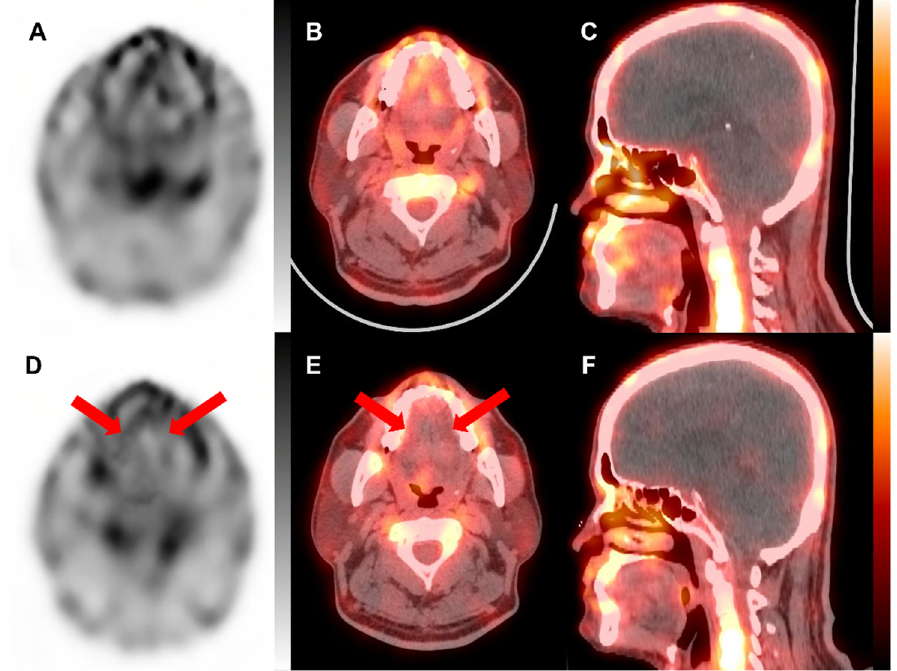
Figure 2. Transaxial single-photon emission computed tomography (SPECT), fused transaxial, and fused sagittal SPECT/computed tomography (CT) images of the tongue on the initial ( A – C ) and follow-up ( D – F ) blood pool SPECT/CT using Tc-99m methylene diphosphonate. On the initial blood pool SPECT/CT images, heterogeneously increased blood pool uptake was seen in the tongue. On the follow-up SPECT/CT images, blood pool uptake was prominently reduced over the entire area of the tongue (arrows on ( D , E )). In the initial SPECT, the tongue showed unevenly increased intake in various areas, but in the follow-up SPECT, the tongue showed an overall decrease.